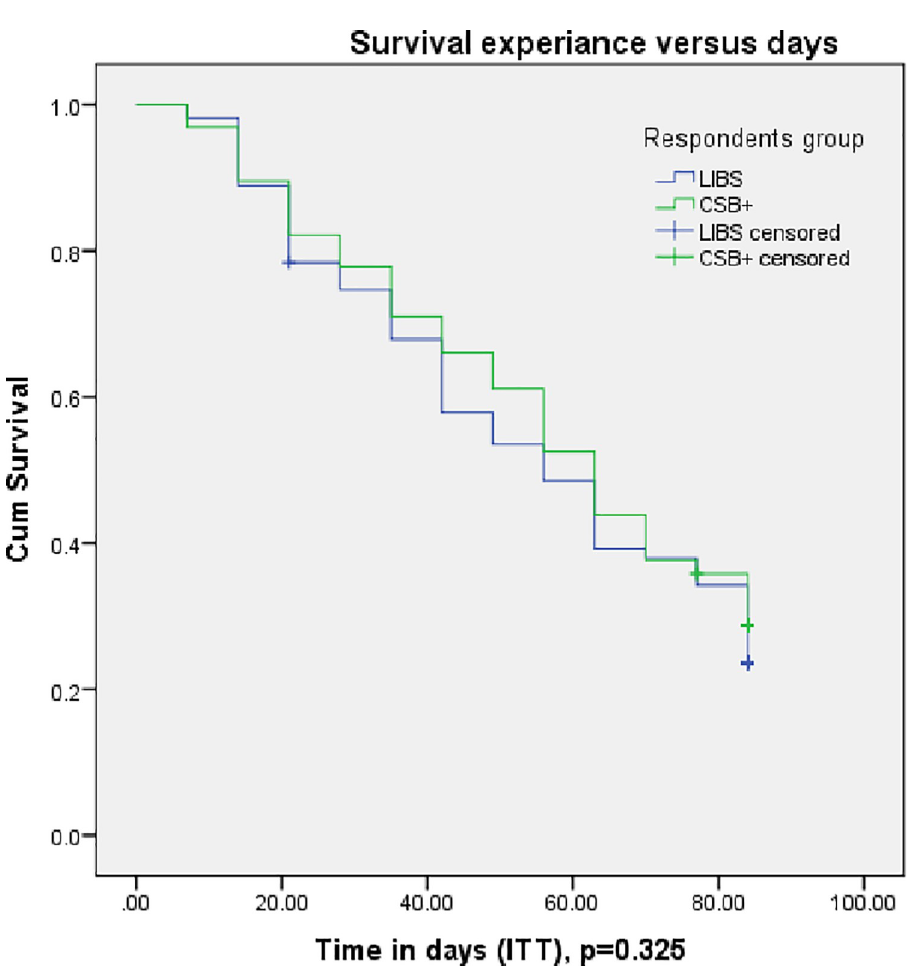
Fig 5. Recovery of children with moderate acute malnutrition over time in the LIBS and CSB+ arms in ITT analysis. The recovery of children with MAM over time in the LIBS group was similar to the CSB+ group. Survival analysis, Kaplan-Meier curves and Log-rank tests were used to analyze and describe the data. Abbreviations: MAM: moderate acute malnutrition; LIBS: local-ingredients-based supplement; CSB+: corn-soy blend plus; ITT: intention to